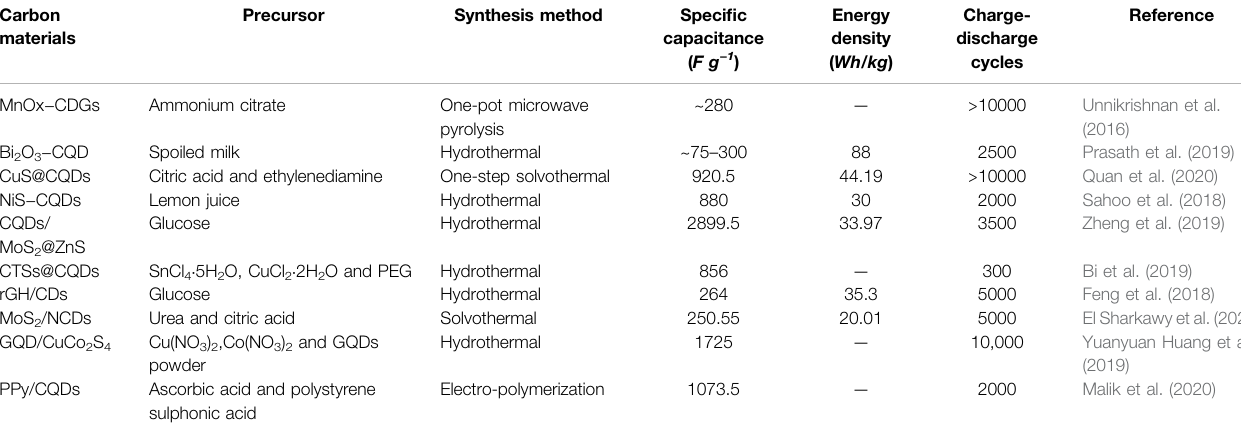
TABLE 4 | CQD-based nanocomposites and their uses in the fabrication of supercapacitors and comparisons of device performance. Carbon